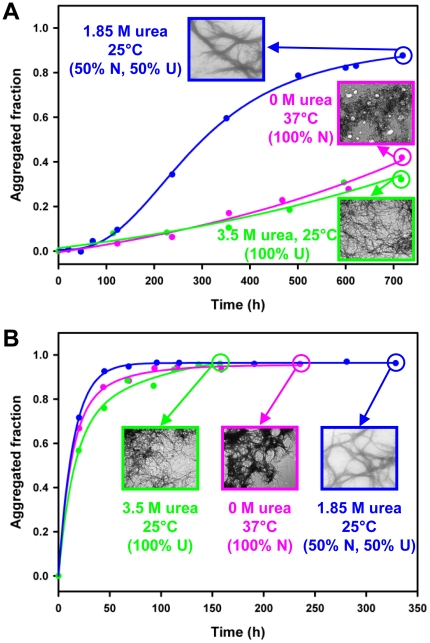
The ability of BlaP(Gln)79 to form amyloid-like fibrils does not depend on the structural integrity of BlaP.Comparison between the aggregation kinetics and the morphology of aggregates obtained with BlaP(Gln)55 (A) and BlaP(Gln)79 (B) under the following conditions of incubation: (i) PBS, pH 7.5 and 0 M urea at 37°C (pink), (ii) PBS, pH 7.5 and 1.85 M urea at 25°C (blue) and (iii) PBS, pH 7.5 and 3.5 M urea at 25°C (green). N is the native state and U is the unfolded state. The data correspond to those shown in Figures 5, 6, 7 without error bars.